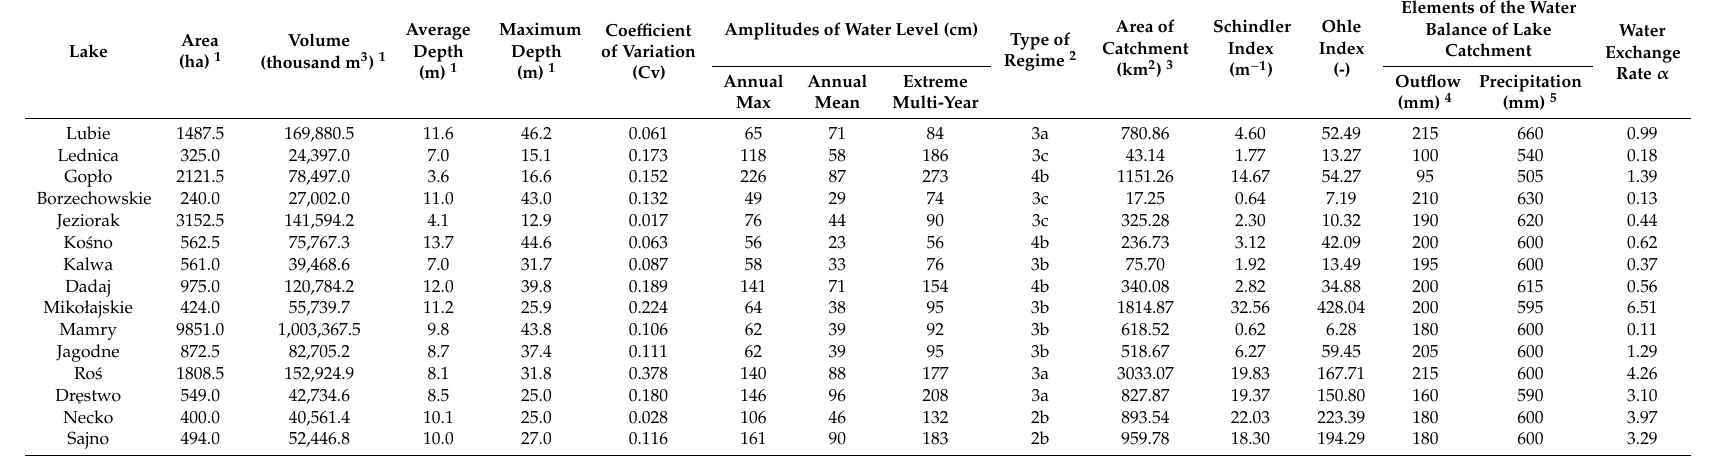
Table 1. Morphometric data of the studied lakes, as well as their water level amplitudes and type of regime of water